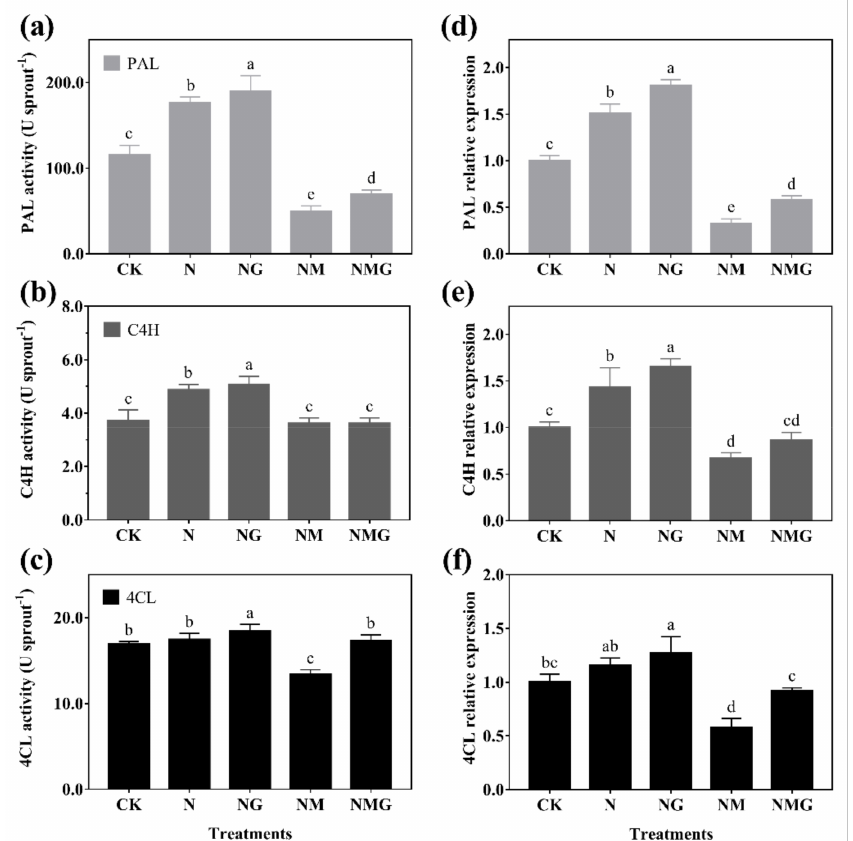
Figure 5. The effect of GABA on PAL activity ( a ), C4H activity ( b ), and 4CL activity ( c ), and their gene expression ( d – f ), for 6-day-old barley seedlings under 20 mmol L − 1 NaCl. The lower case letters indicate significant differences at p < 0.05 among different treatments. One-way ANOVA was used. The data are presented as mean ± SD, n =